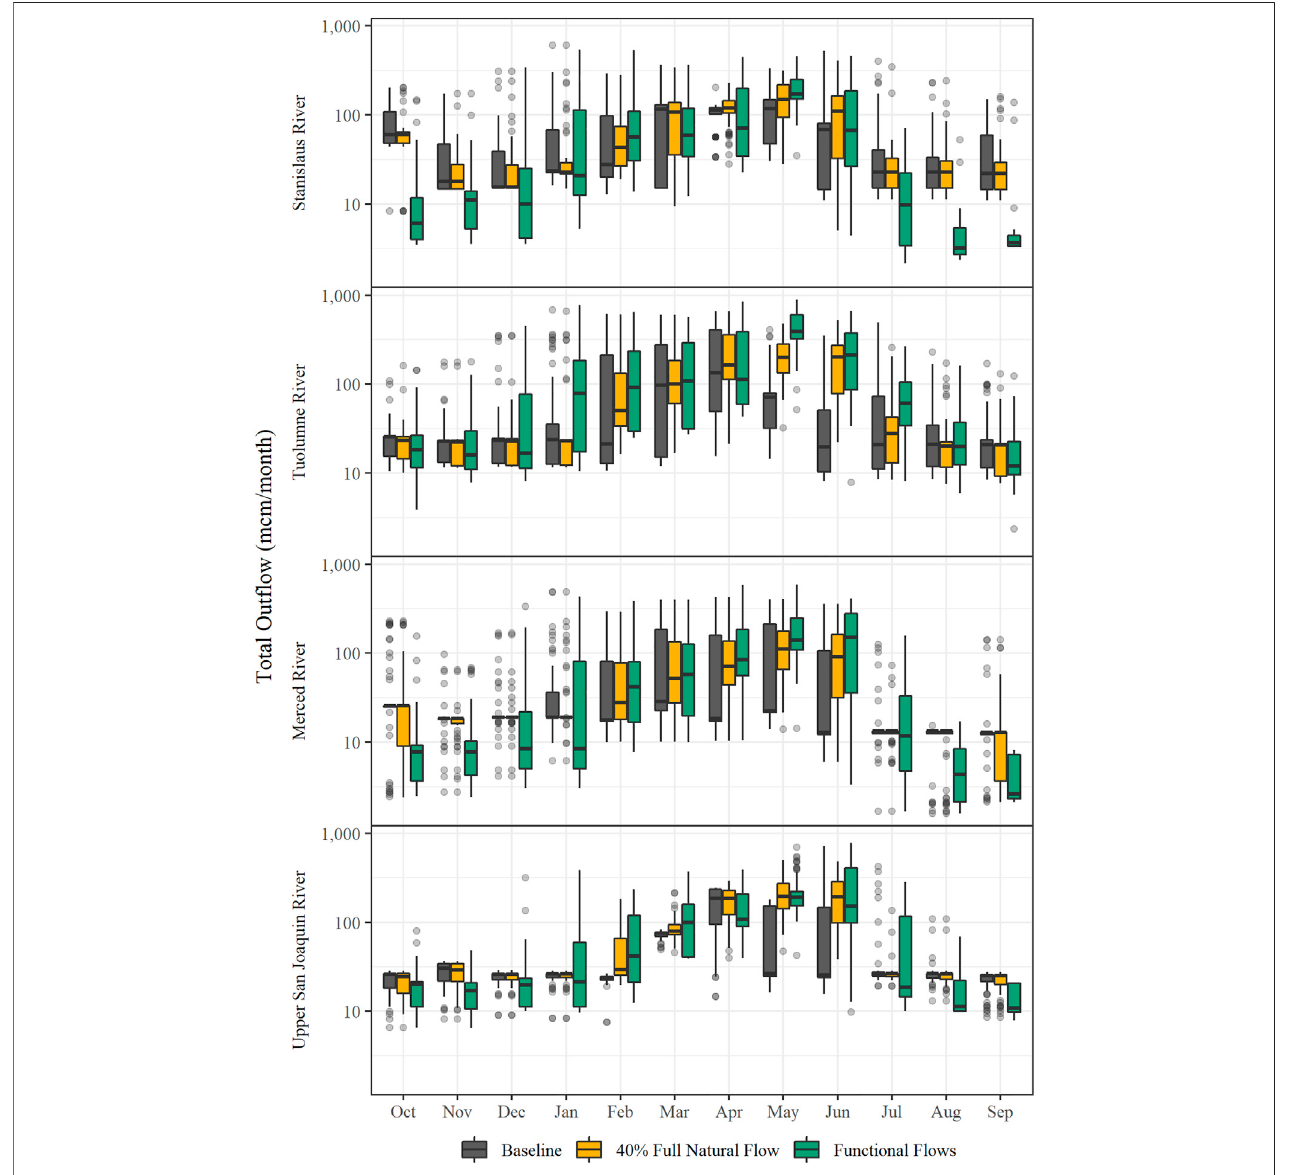
FIGURE 4 | Total out fl ow from each of the four basins for three strategies: baseline, 40% FNF, and functional fl ows. Note log scale y -axis.